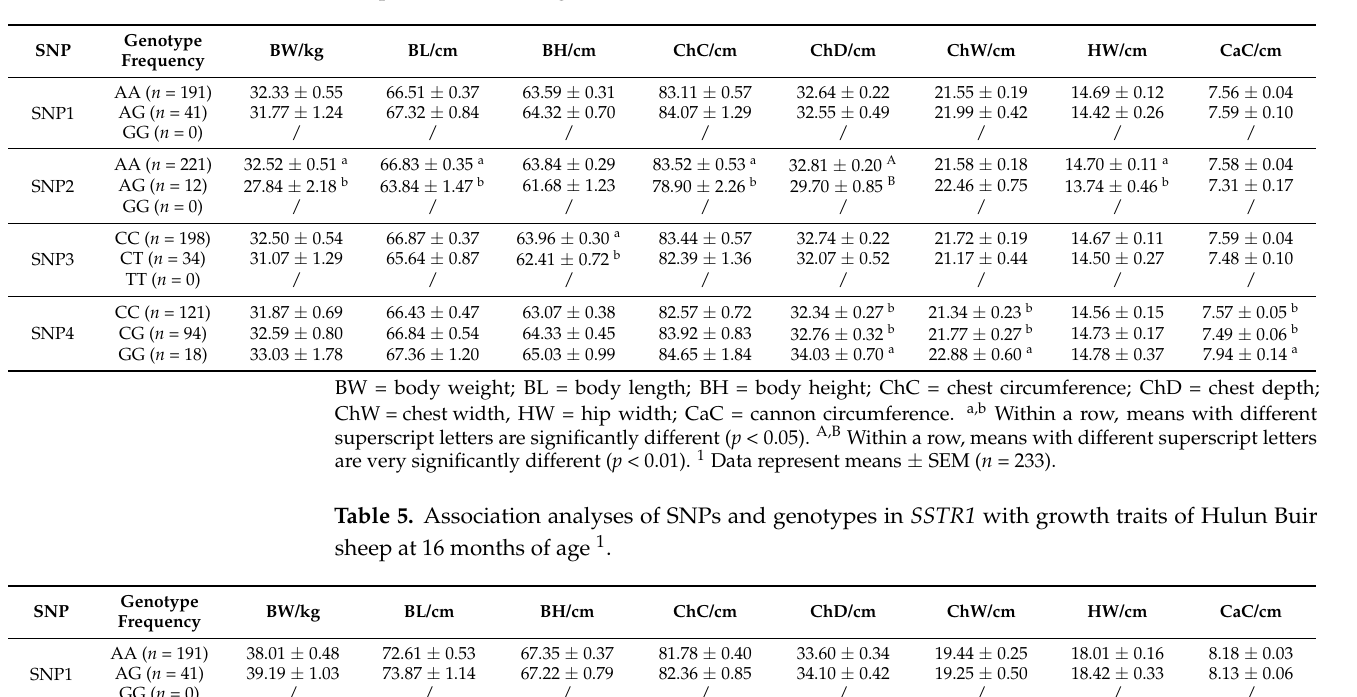
Table 4. Association analyses of SNPs and genotypes in SSTR1 with growth traits of Hulun Buir sheep at 9 months of age 1 .